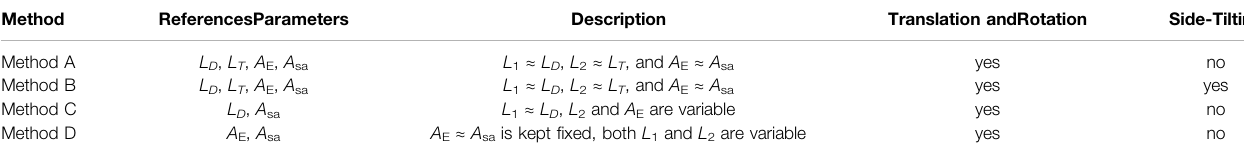
TABLE 1 | Method of searching the optimal reference ellipse for constructing the most appropriate ICS.